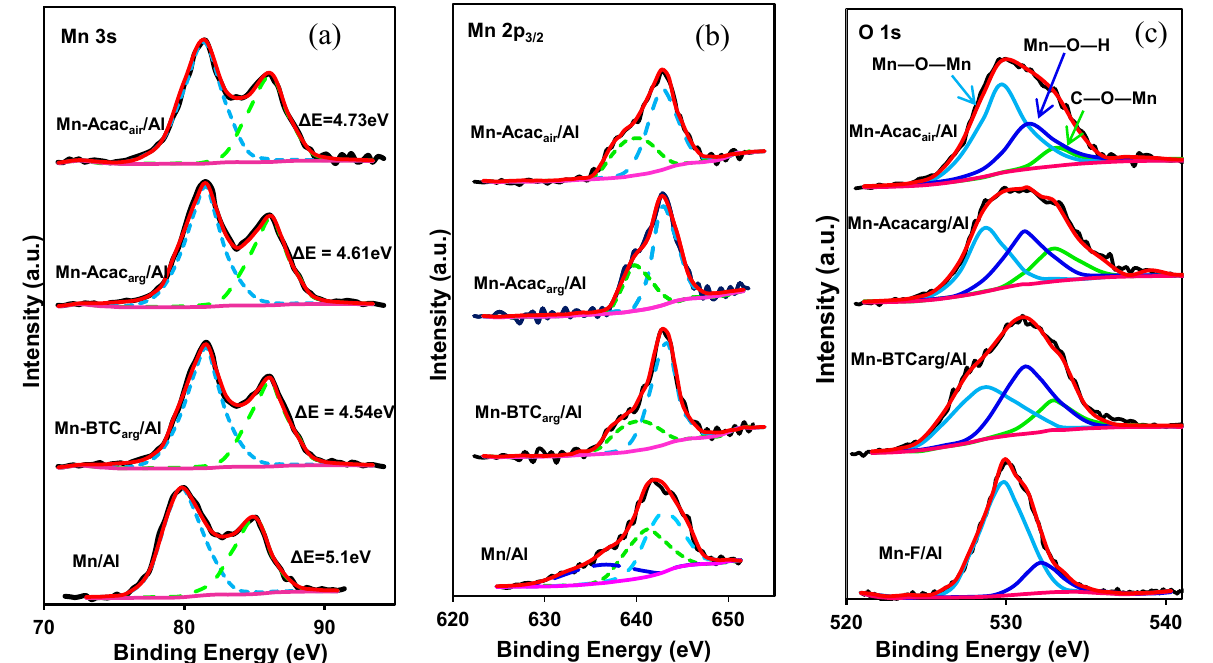
Figure 5. The XPS spectra of Mn/Al, Mn-Acac air /Al, Mn-Acac arg /Al and the Mn-BTC arg /Al catalysts;